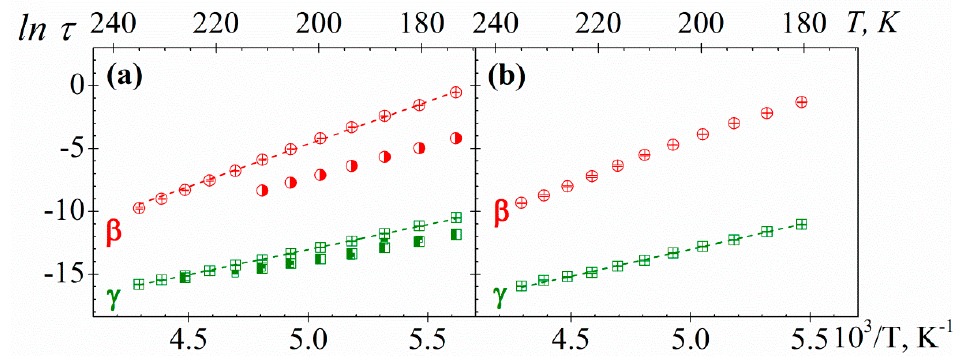
Figure 12. Arrhenius plot for γ (squares) and β (circles) relaxations of ( a ) PAzMa1 and ( b ) PAzMa2 samples. In ( a ) has been shown the time relaxation values corresponding to the PEOEMA (square with right half black, circle with right half black) and CEOEMA (square with top half black) samples [9].